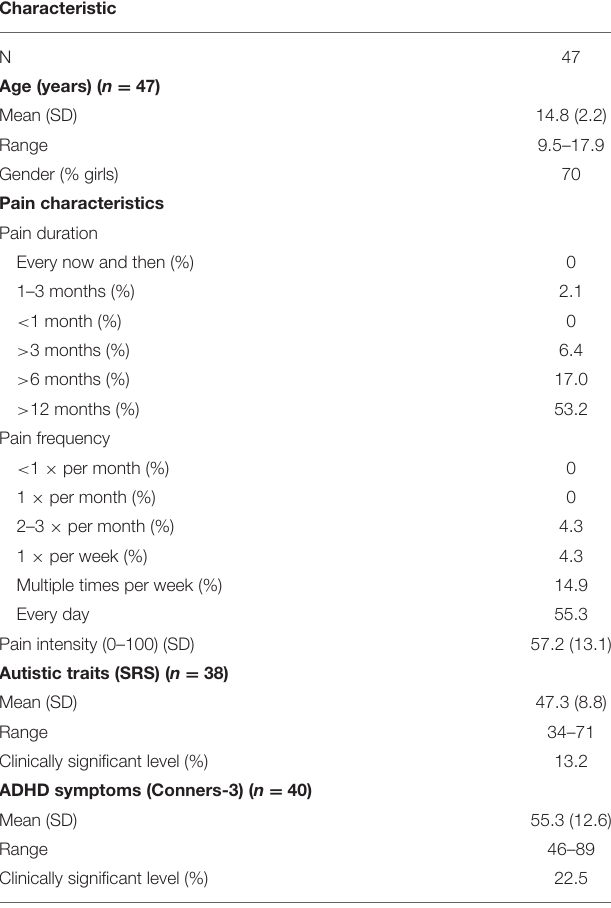
TABLE 1 | Descriptive characteristics of the study